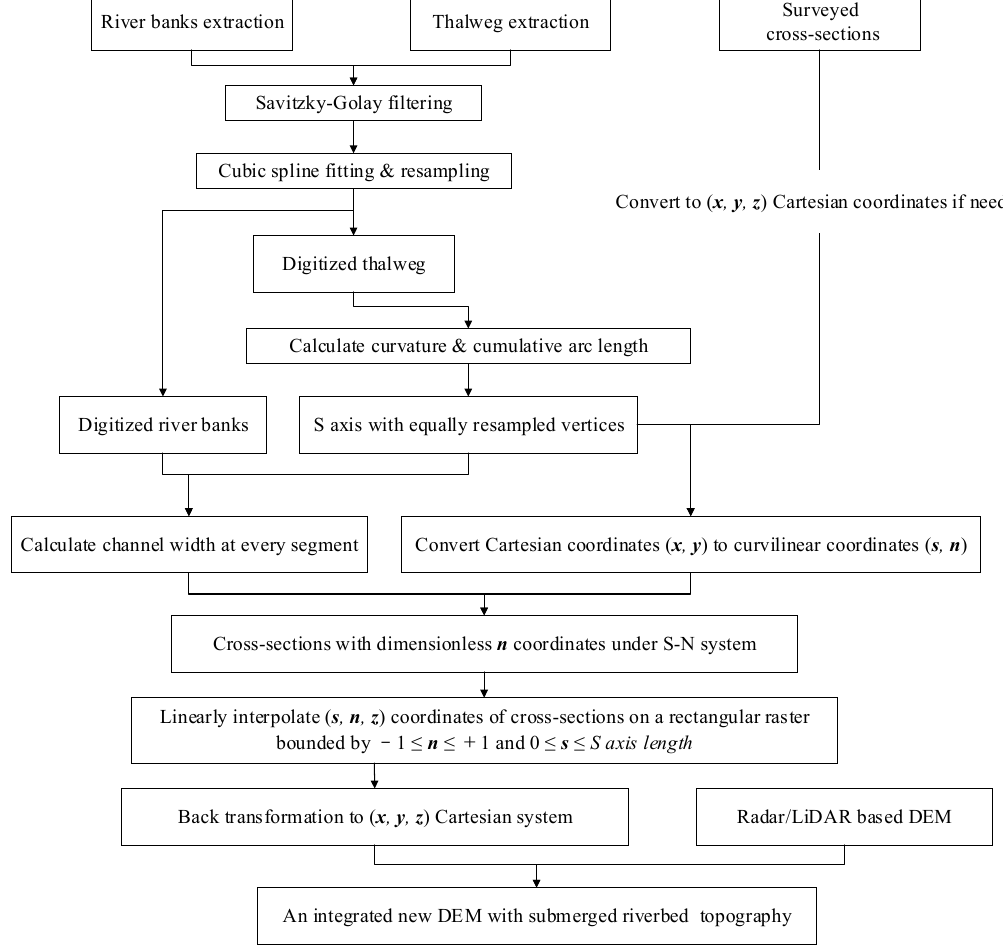
Figure 2. Flow chart of the integrated digital elevation model (DEM) reconstruction process.